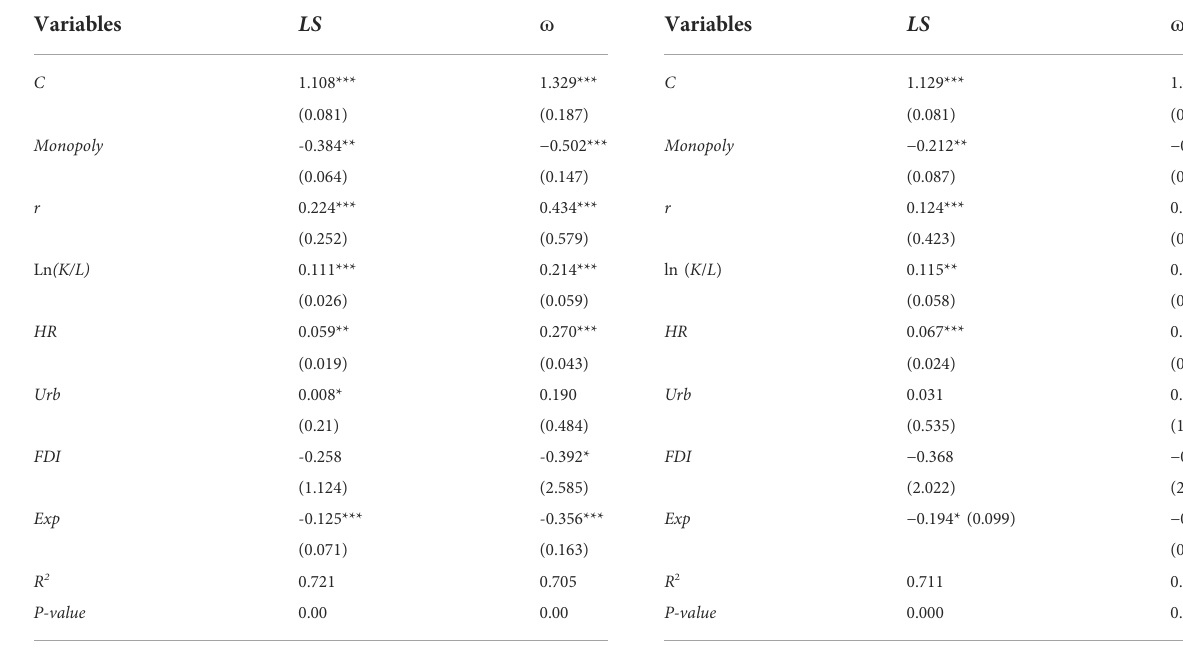
TABLE 5 Regression results for dependent variable labor income. TABLE 6 Results of the robustness